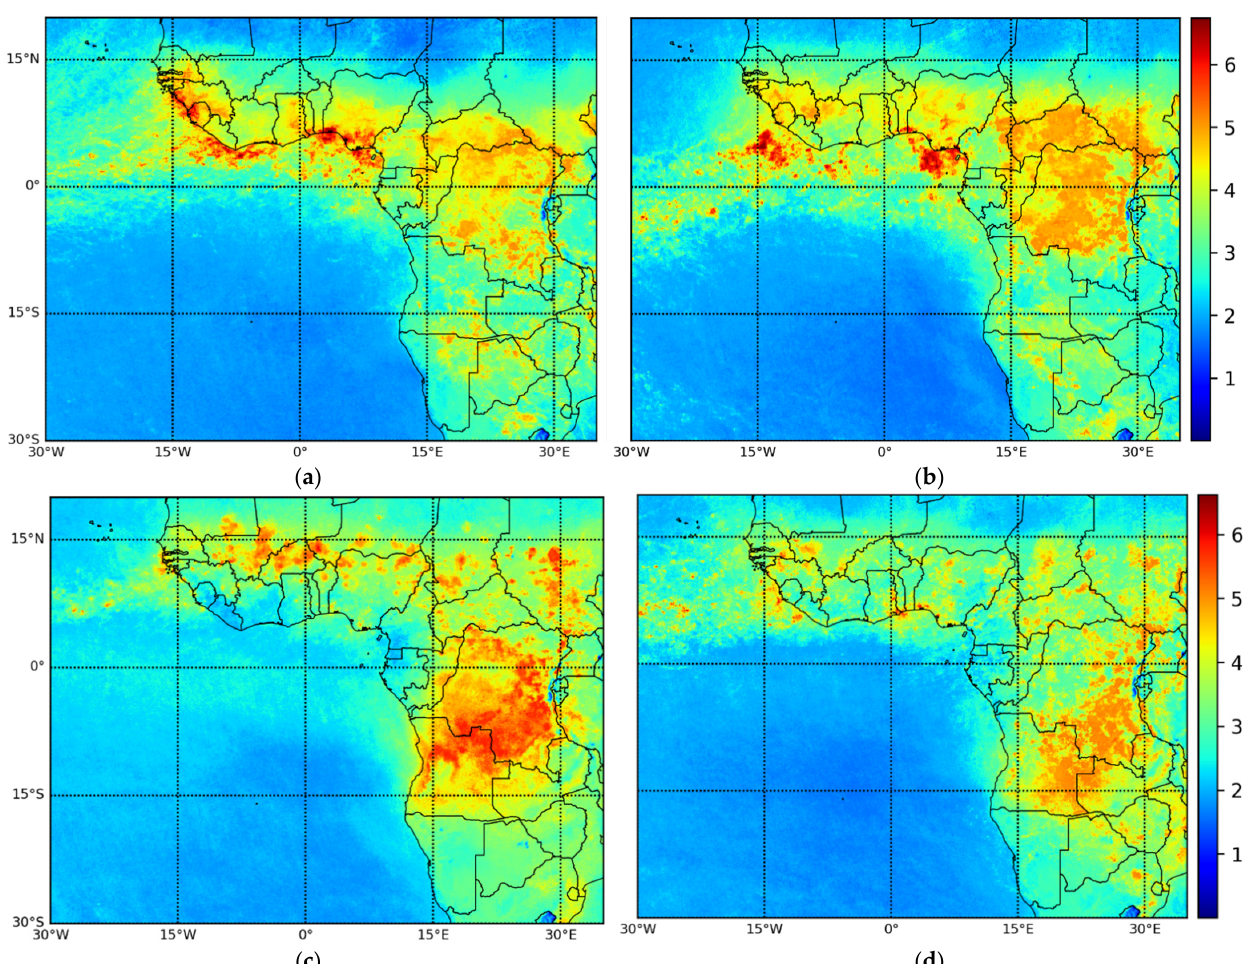
Figure 12. Surface concentration of HCHO in Central and South Africa in some typical months: ( a ) January; ( b ) April; ( c ) July; ( d ) October. (unit: μ g/m 3 ).